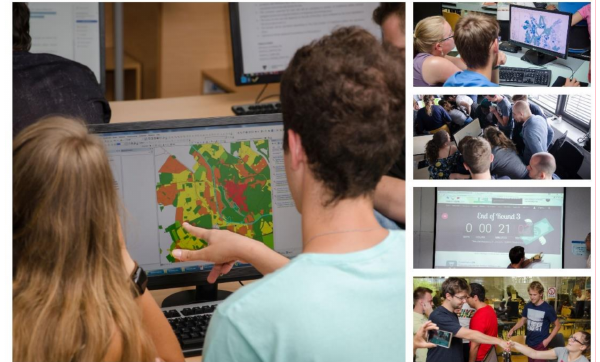
Figure 4. Illustration of the simulation game working environment (performing analysis, discussions, deals). Source: